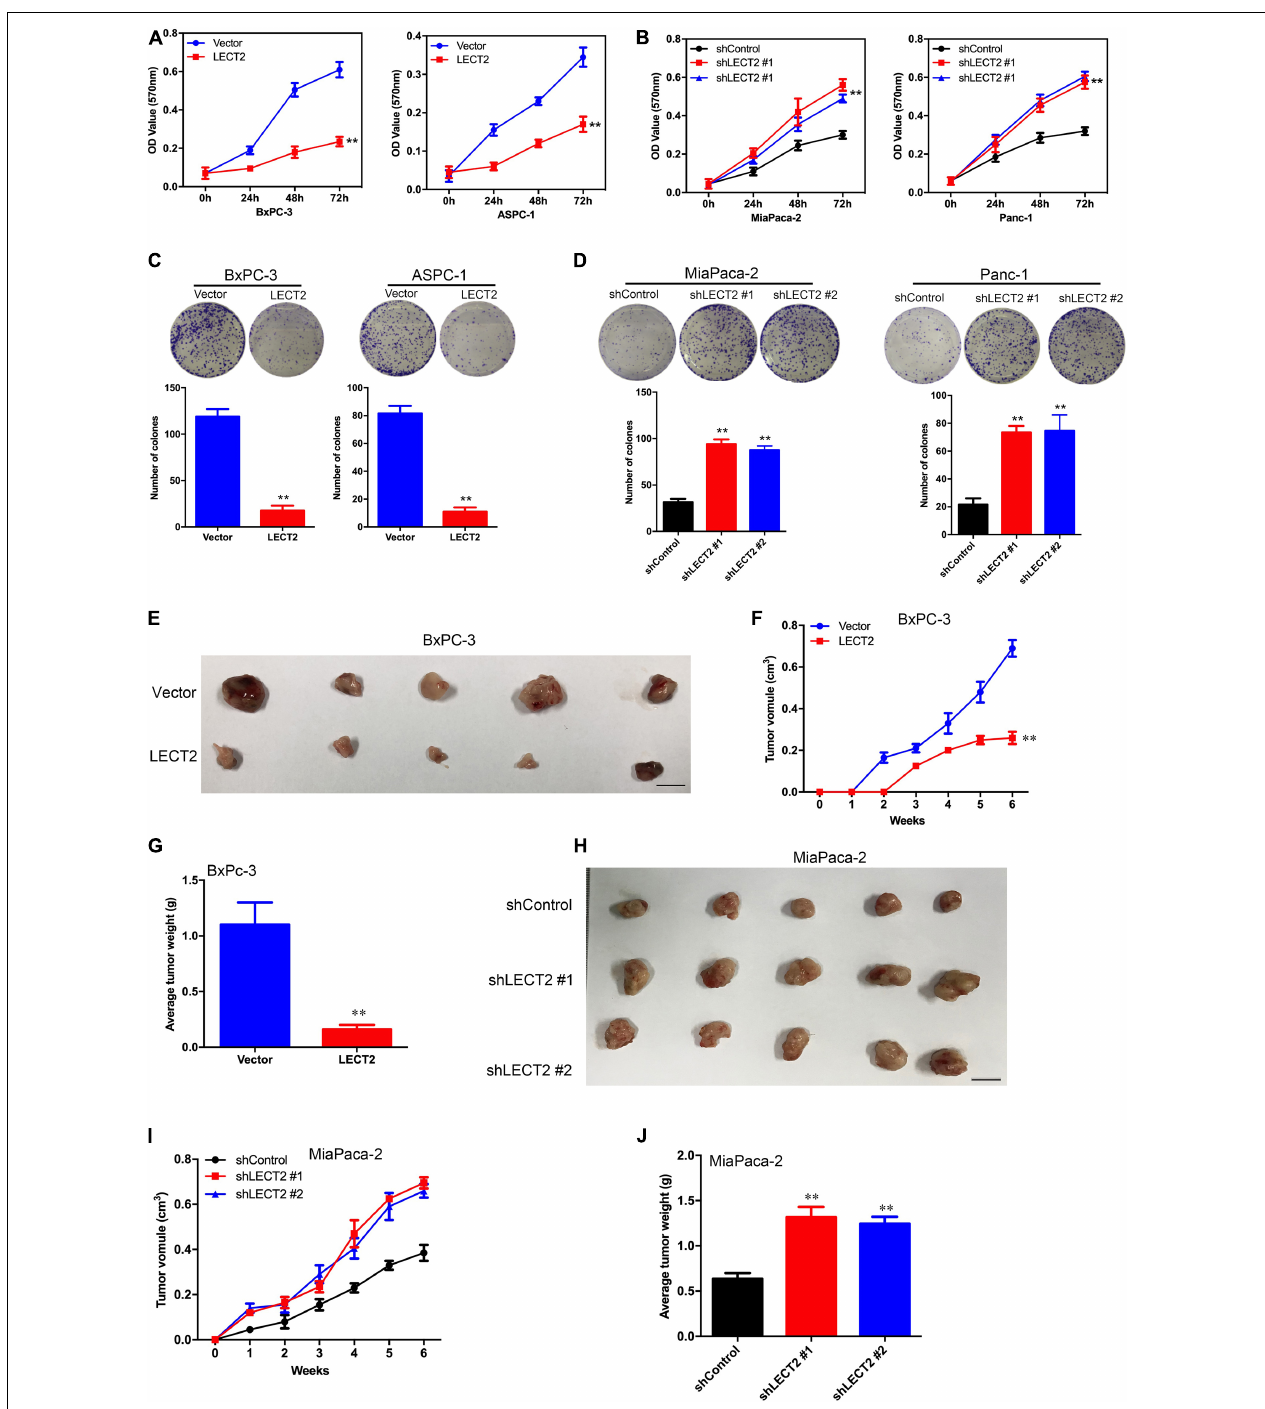
FIGURE 2 | LECT2 regulates cell proliferation, colony formation, and tumor growth in PDAC. (A) Cell proliferation of BxPC-3 (left) and ASPC-1 (right panel) cells transfected with control (blue) or LECT2 (red) vector. (B) Cell proliferation of MiaPaca-2 (left) and Panc-1 (right panel) cells transfected with shControl (black) or shLECT2 (red and blue) vectors. (C) Colony formation of BxPC-3 (left) and ASPC-1 (right panel) cells as described in (A) . (D) Colony formation of MiaPaca-2 (left) and Panc-1 (right panel) cells as described in (B) . (E–G) BxPC-3 cells (1 × 10 6 ), as described above, were injected subcutaneously into the mice ( n = 5 for each group), and the resulting tumors in each group were measured once a week. Photographs of tumors isolated from the mice (E) , the tumor volume (F) , and the weights of the tumors (G) are shown. (H–J) MiaPaca-2 cells (1 × 10 6 ), as described above, were injected subcutaneously into the mice ( n = 5 for each group), and the resulting tumors in each group were measured once a week. Photographs of tumors isolated from the mice (H) , the tumor volume (I) , and the weights of the tumors (J) are shown. Scale bar = 1 cm in (E) and (H) . ** p < 0 . 01.